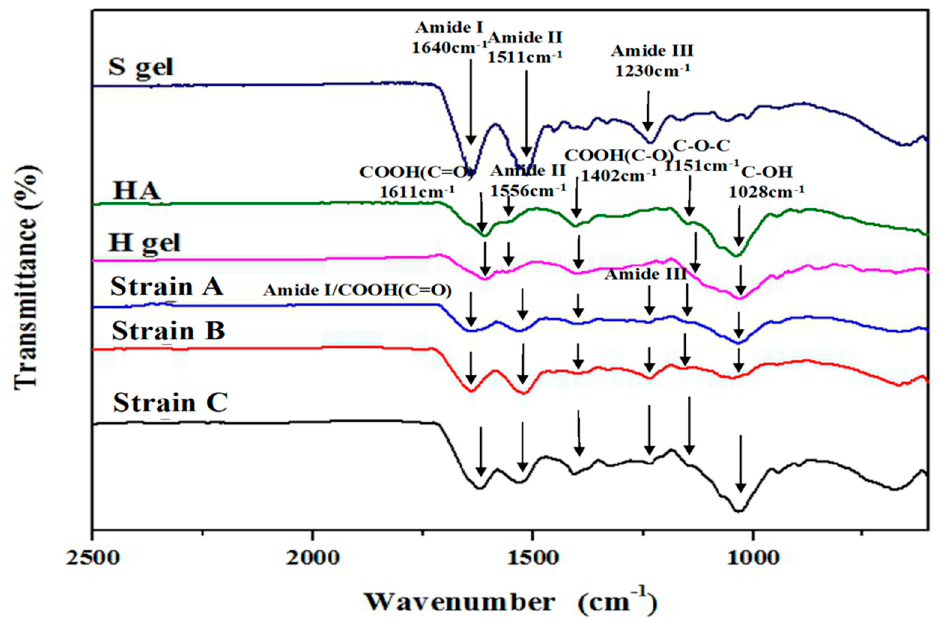
Figure 1. ATR-FTIR transmission spectra of varying functional groups of SF, HA polymers, and H, S and HS7-IPN hydrogels. The characteristic peaks of H hydrogels such as carboxyl groups (COOH), and S hydrogels such as amide I, II and III, respectively, were found in HS-IPN hydrogels without varying by the SF of strains of A, B and C.